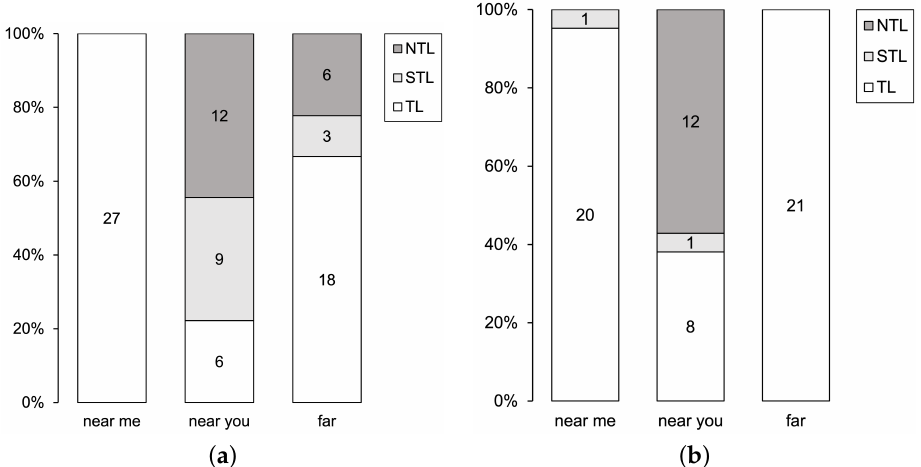
Figure 2. Overview of results for picture sentence matching task ( a ) and semi-guided production ( b